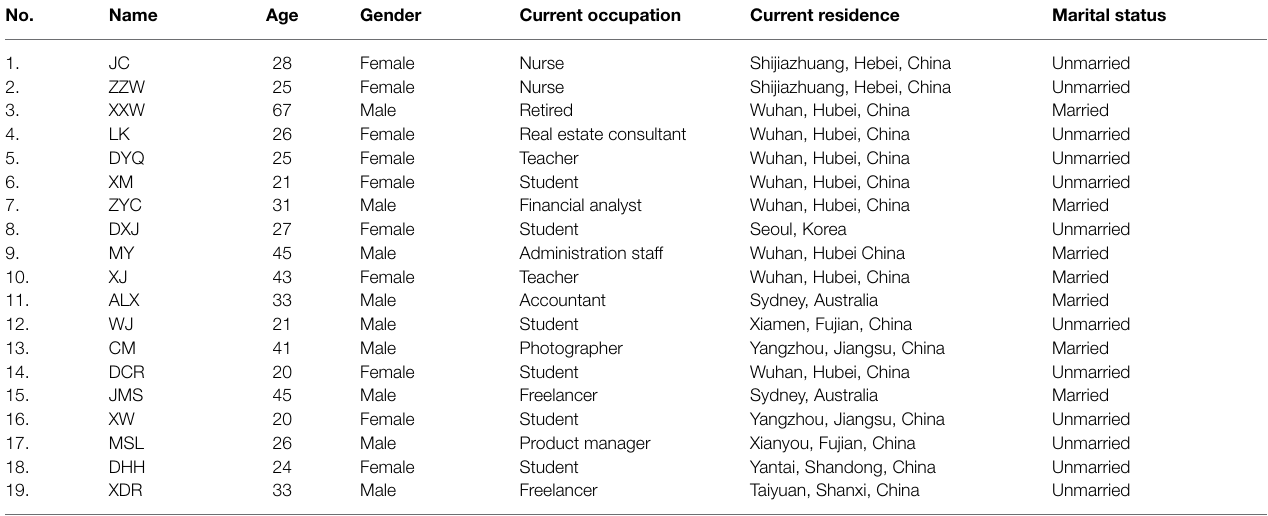
TABLE 2 | Basic information of participants. No. Name